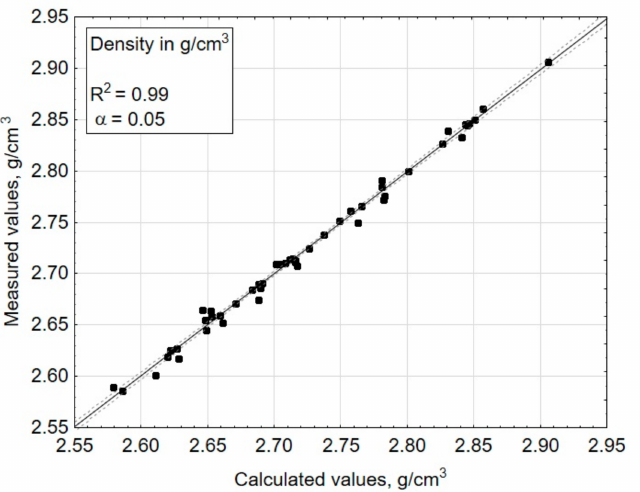
Figure 7. Comparison of the measured values (experimentally tested) and the estimated values (calculated using the chosen mathematical model)—for a dependent variable: density in g/cm 3